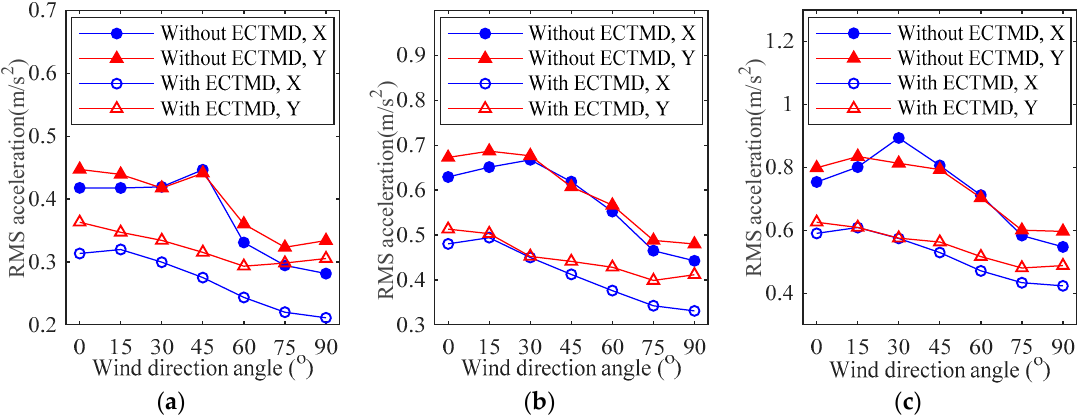
Figure 19. Variation of RMS acceleration with wind direction and wind speed. ( a ) 18.5 m/s; ( b ) 22.6 m/s; ( c ) 24.7 m/s.